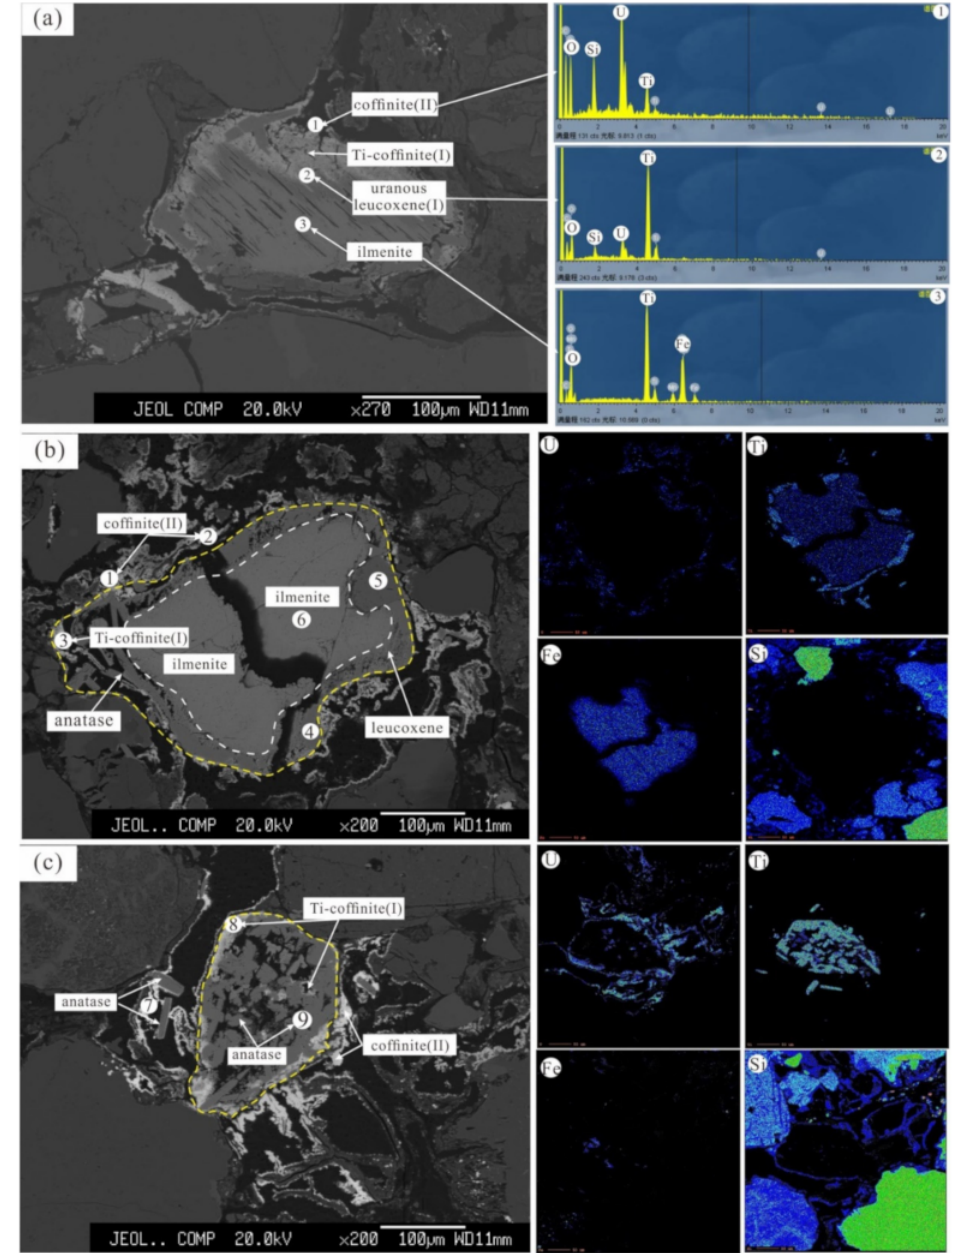
Figure 4. Geochemical characteristics of altered ilmenite and U minerals in sandstone-hosted U deposits in the Nalinggou U deposit in the northern Ordos Basin. ( a ) Partially altered ilmenite with minor amounts of residual ilmenite and mineral assemblage sequence of ilmenite, porous leucoxene, uraniferous leucoxene, Ti-coffinite and coffinite (BSE). ( b ) Partially altered ilmenite with minor amounts of residual ilmenite and mineral assemblage sequence of ilmenite, porous leucoxene, anatase, Ti-coffinite and coffinite (BSE). ( c ) Completely altered ilmenite replaced by anatases, Ti- coffinite and coated by coffinite